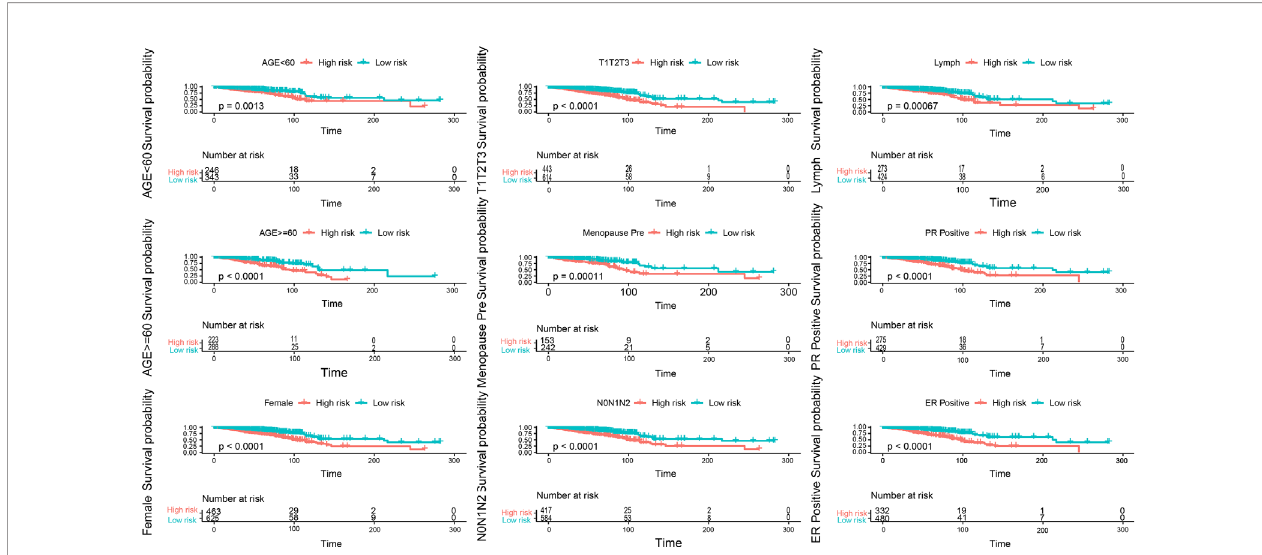
FIGURE 7 | Evaluation of indicators related to breast cancer in the sample, blue is the low-risk group, light red is the high-risk group, each picture is a sample of different